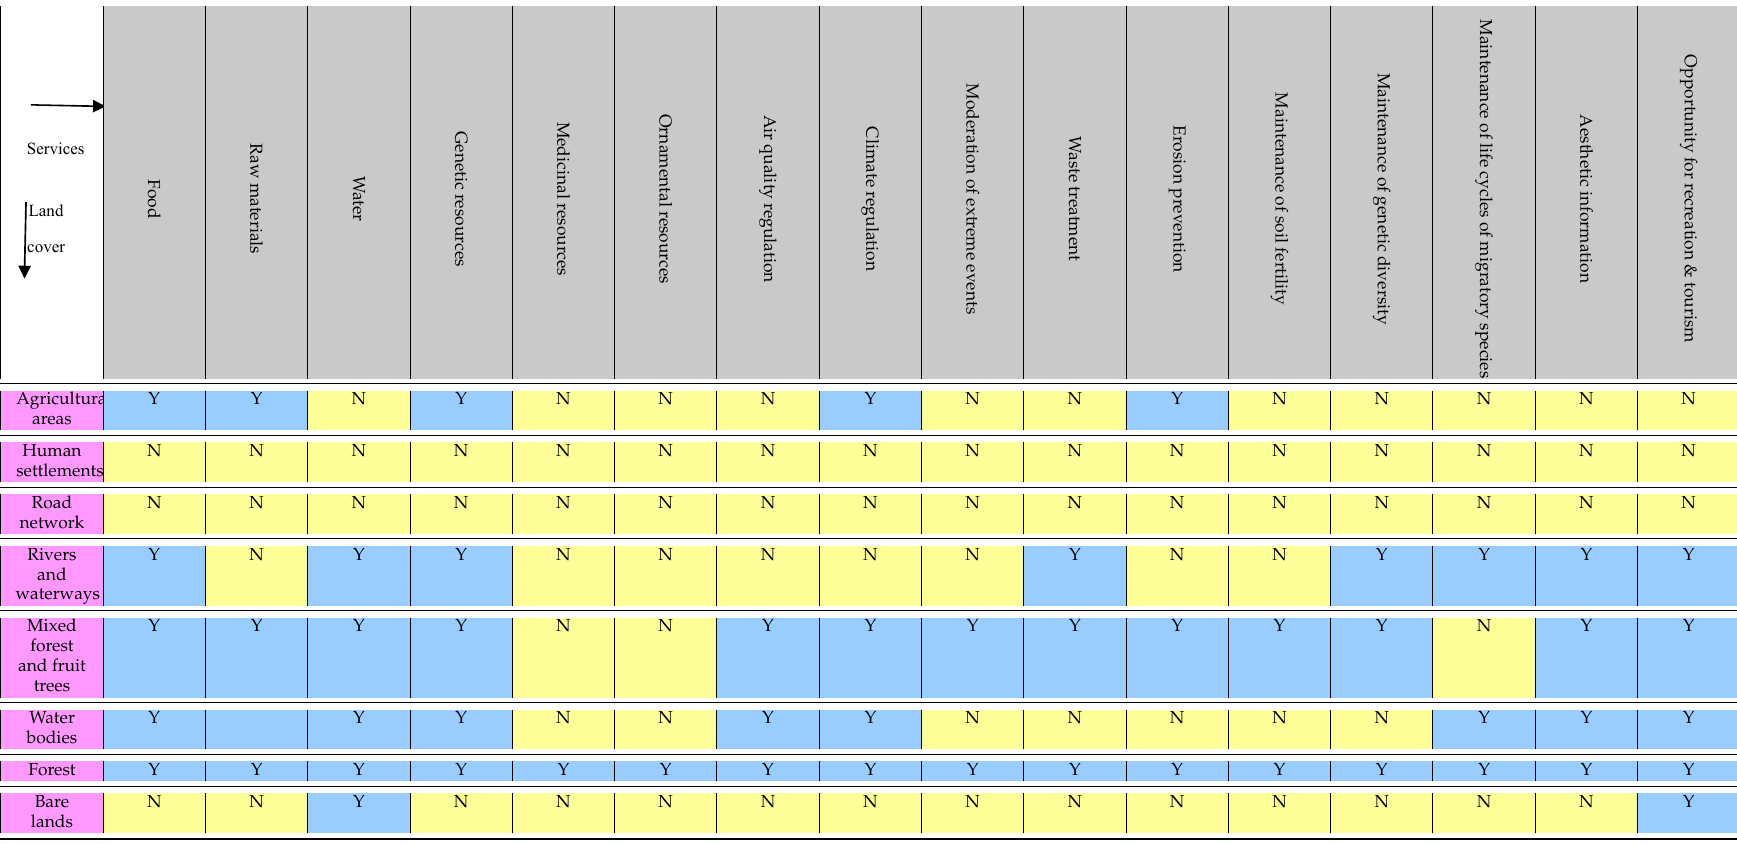
Table A4. The matrix which was used to specify the relationship or disaffiliation between each LULC class and different types of ES.